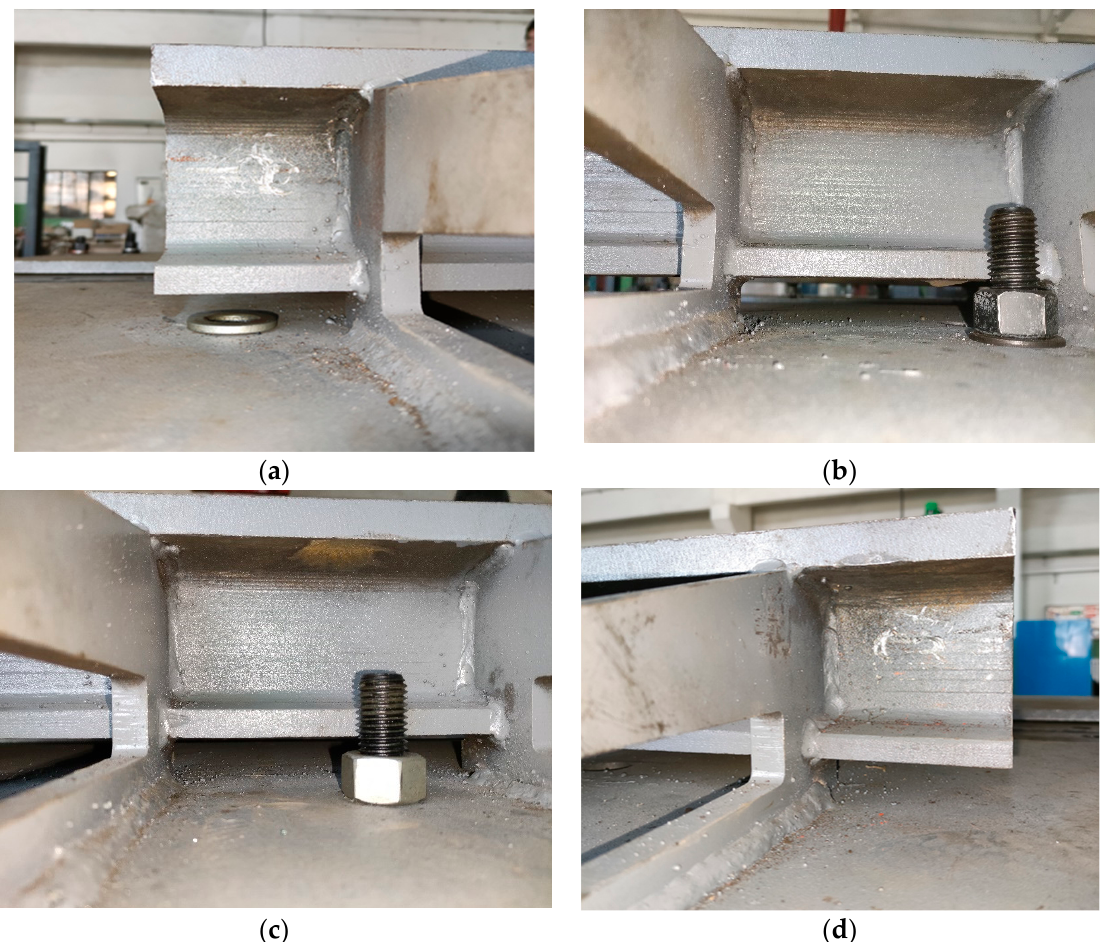
Figure 22. The comb plate expansion joint after fatigue test: ( a )The picture of the expansion joint from the main view, ( b ) The picture of the expansion joint from the top view.